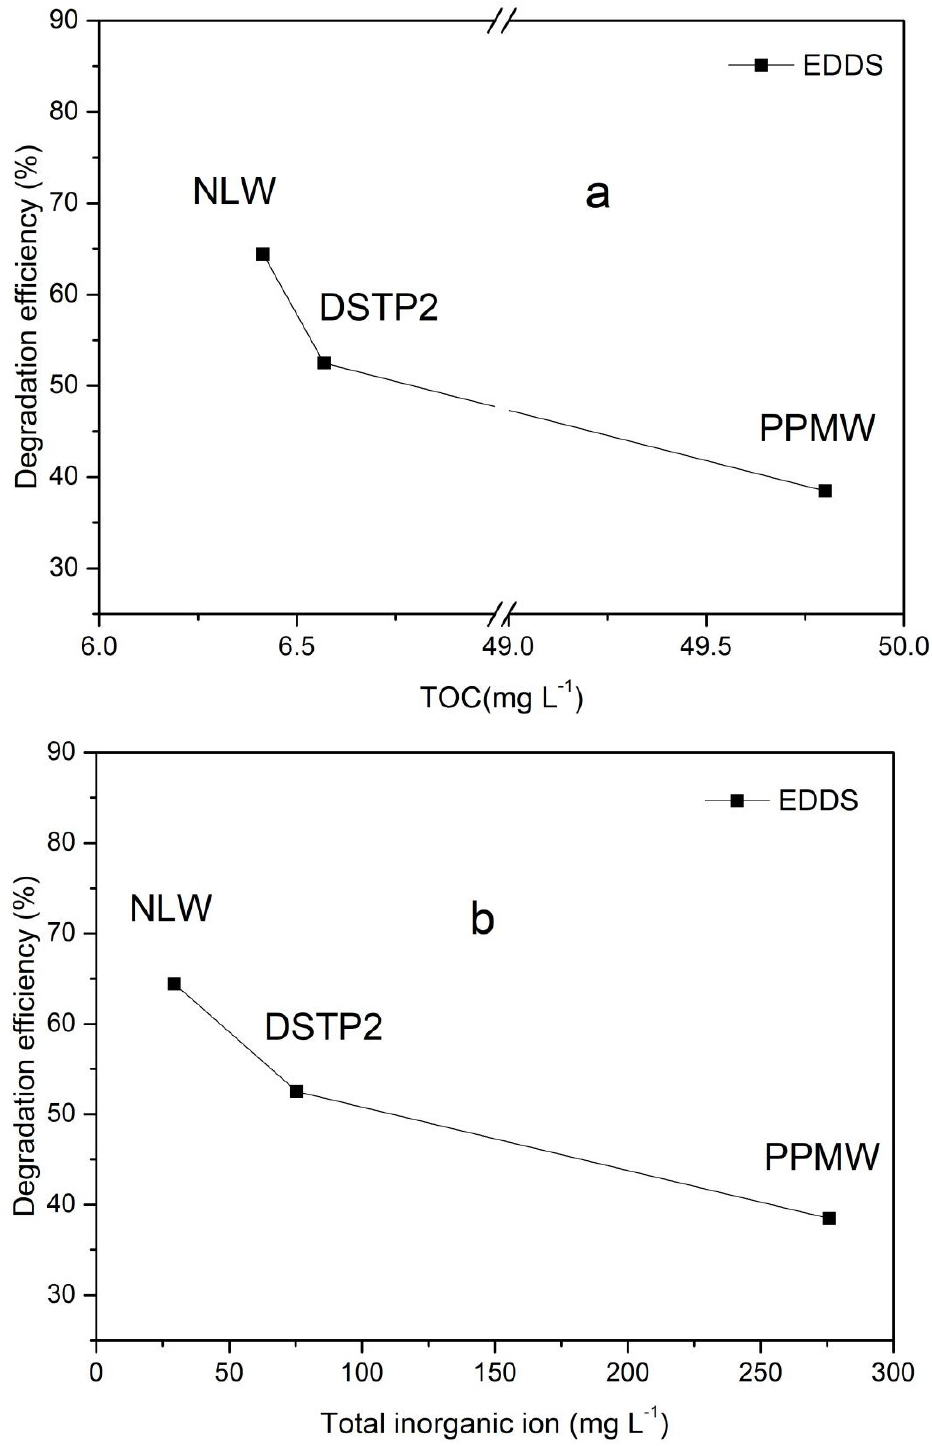
Figure 8. Effects of ( a ) TOC and ( b ) total inorganic ion concentration on 2,4-DCP degradation effi- ciency in different water bodies. [2,4-DCP] = 20 mg L − 1 , [Fe(III)-EDDS] = 0.1 mM, [H 2 O 2 ] = 1.0 mM, and pH = 7.0 ± 0.1.